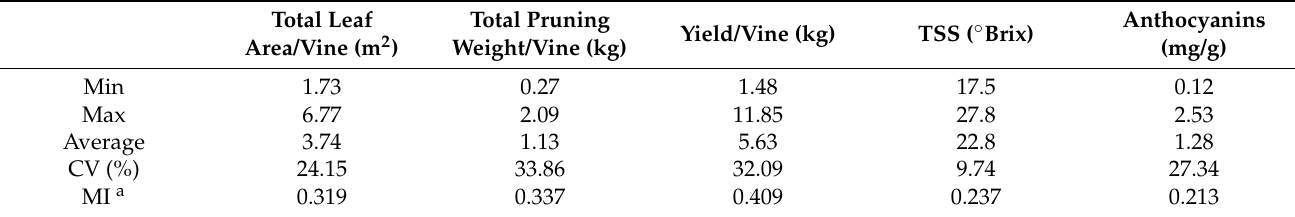
Table 1. Total leaf area, winter pruning weight per vine, yield/vine, cluster weight, total soluble solids, total anthocyanins on field-grown cv. Barbera grapevines ( n =